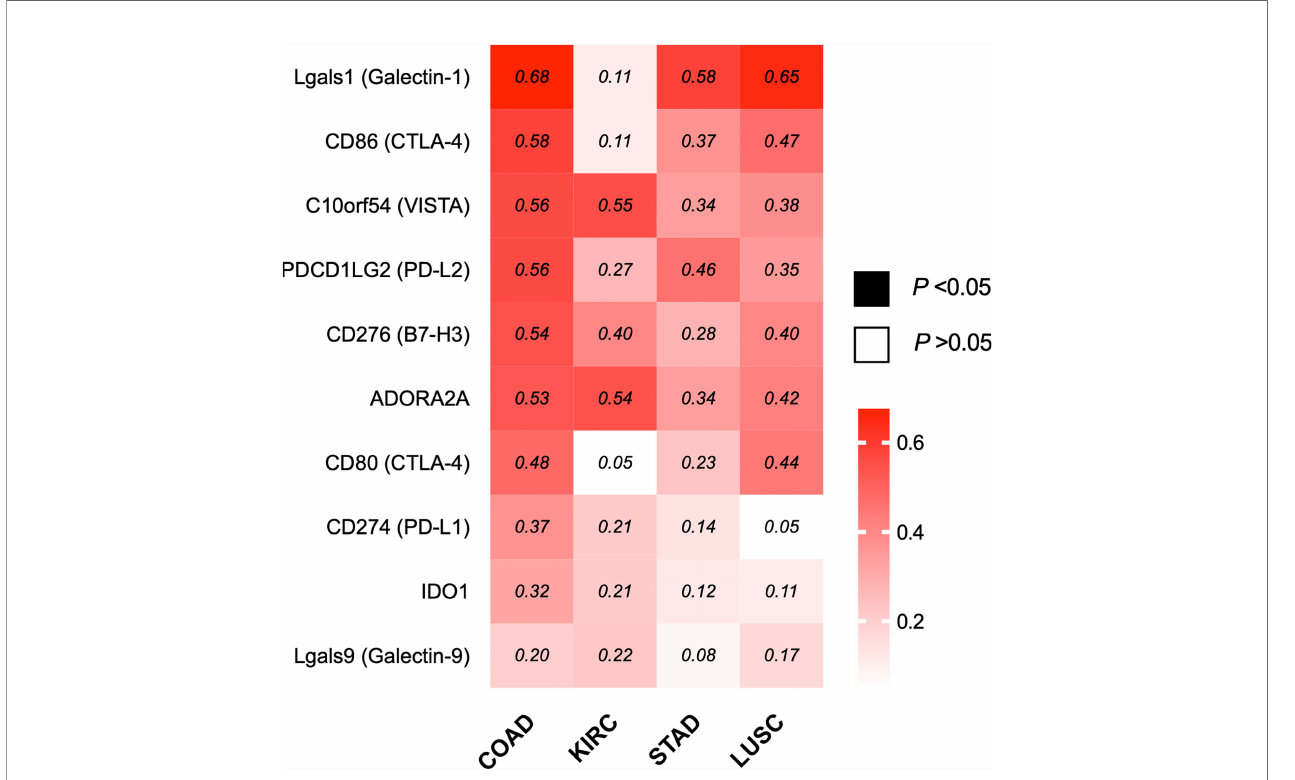
FIGURE 8 | ILK expression is signi fi cantly correlated with several immune inhibitory genes in COAD. Heat map of different immune inhibitory genes and their correlation with ILK in COAD, KIRC, STAD and LUSC via GEPIA. The values in the heat map are Spearman ’ s Rho values (R). The scale on the right of the heat map is for R values. The colored squares are statistically signi fi cant while the white squares are not statistically signi fi cant. The R values that are above 0.08 are statistically signi fi cant. Signi fi cant P -value is